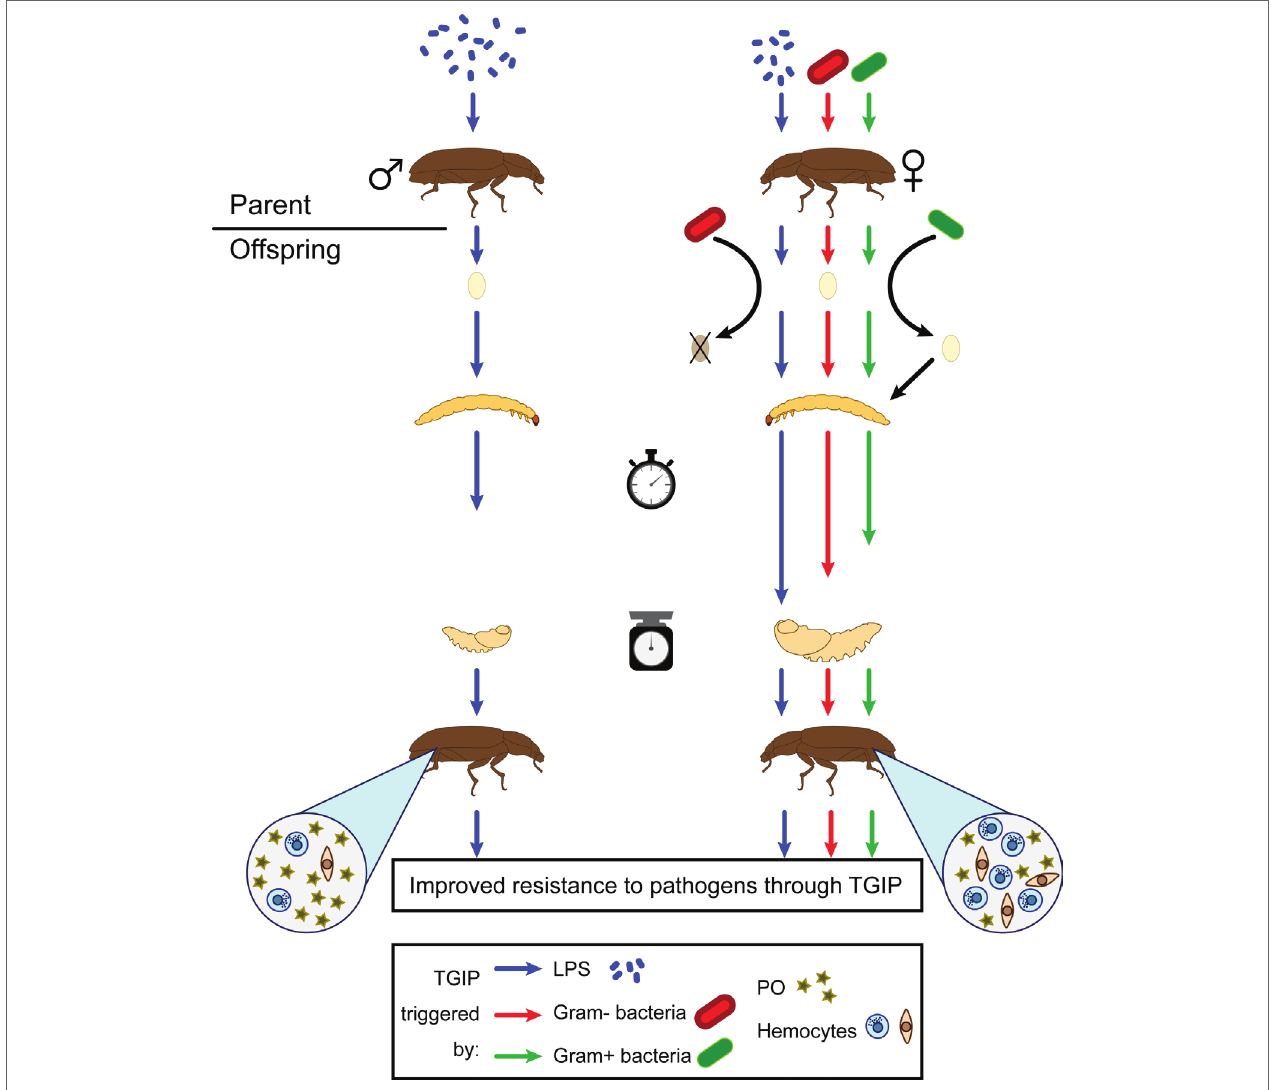
FIGURE 5 | Subsequent effects of TGIP on T. molitor offspring traits. TGIP enhances offspring resistance to pathogens if either the father (left) or the mother (right) has been primed. However, the sex of the parent triggering the TGIP produces different consequences on the offspring traits. Offspring originated from a mother primed with either LPS (blue), Gram-negative bacteria (red), or Gram-positive bacteria (green) are also affected differently by the TGIP. Larval developmental time (stopwatch) is represented by the length of the arrows between larvae and pupae (arbitrary scale). Weight of the pupae (scale) is represented by the size of the scheme at this stage (arbitrary scale). Density of hemocytes and hemolymph phenoloxidase (PO) activity is represented by the relative abundance of their corresponding symbols in the circles originated from the offspring